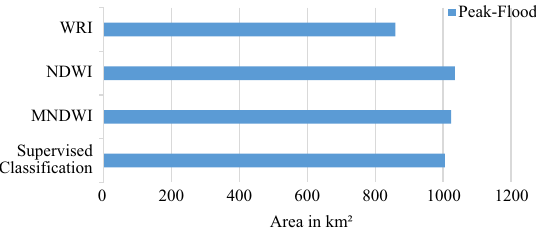
Fig. 9 A graph showing comparison of Peak-Flood-2014 Inundation using SC, MNDWI, NDWI, and WRI